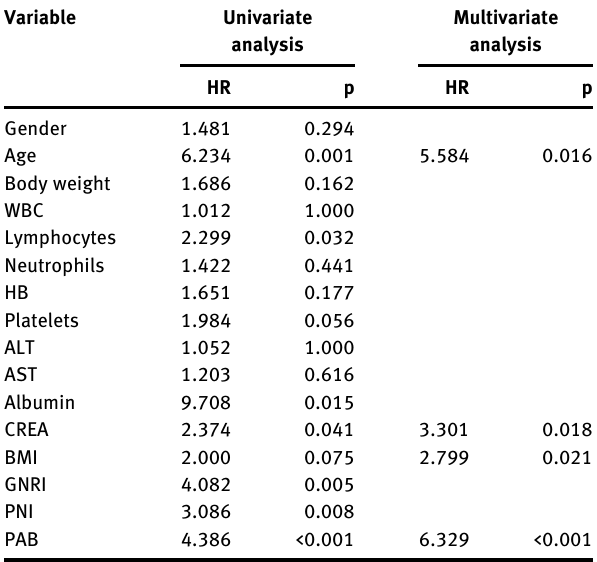
Table  : Univariate and multivariate analyses of in-hospital mortality in critically unites